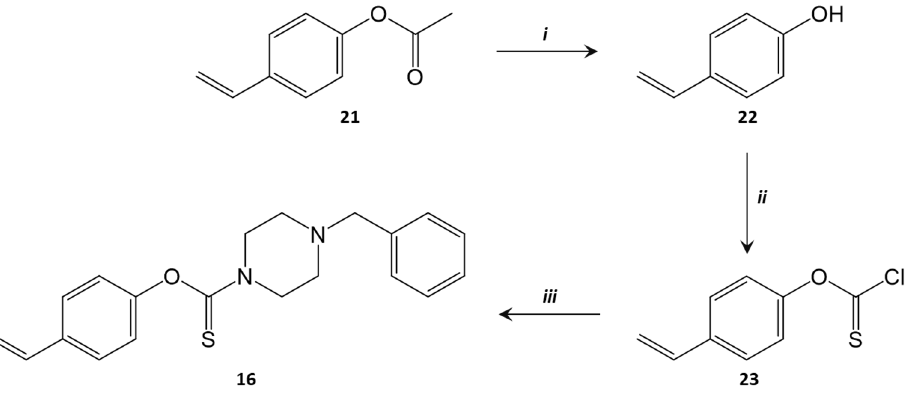
Figure 5. Chemical structure of O -4-vinyl 4-benzylpiperazine-1-carbothioate or benzylpiperazine (4-vinylphenyl) carbamate ( 16 ).